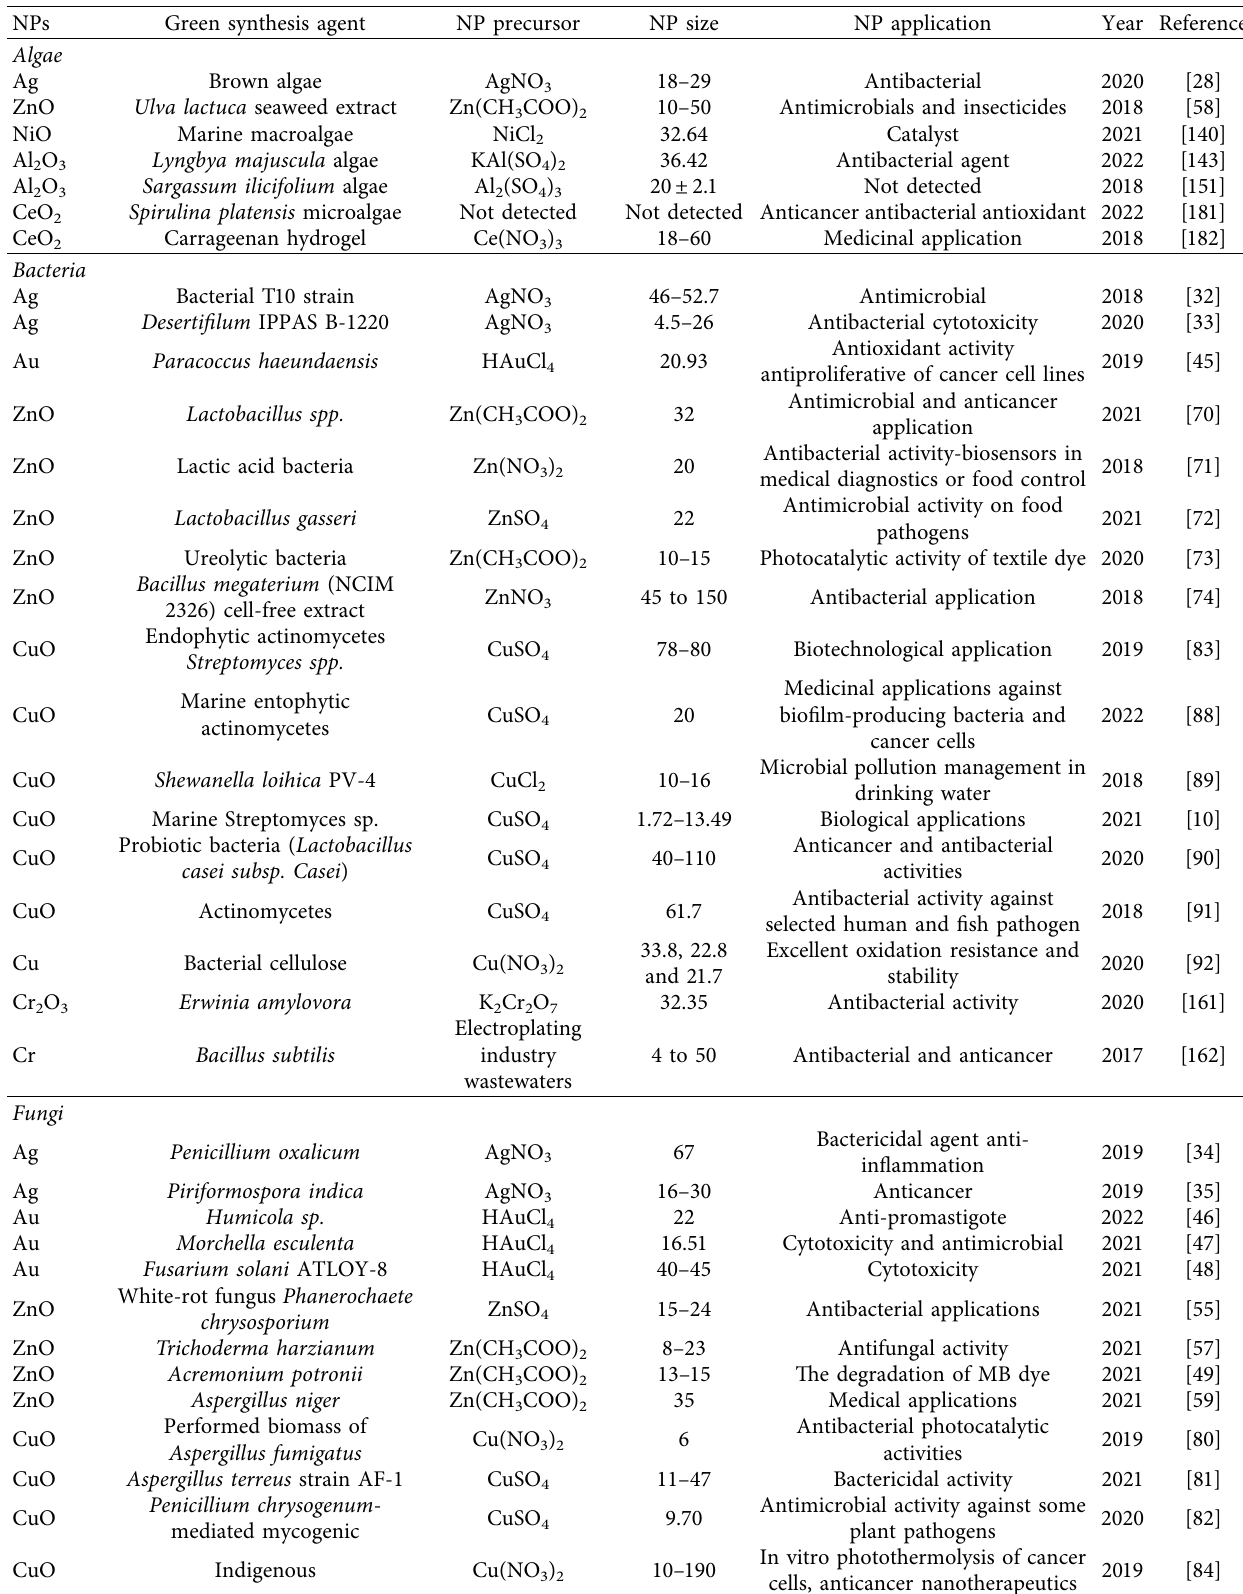
Table 3: Most important characteristics of nanoparticles synthesized using microorganisms.